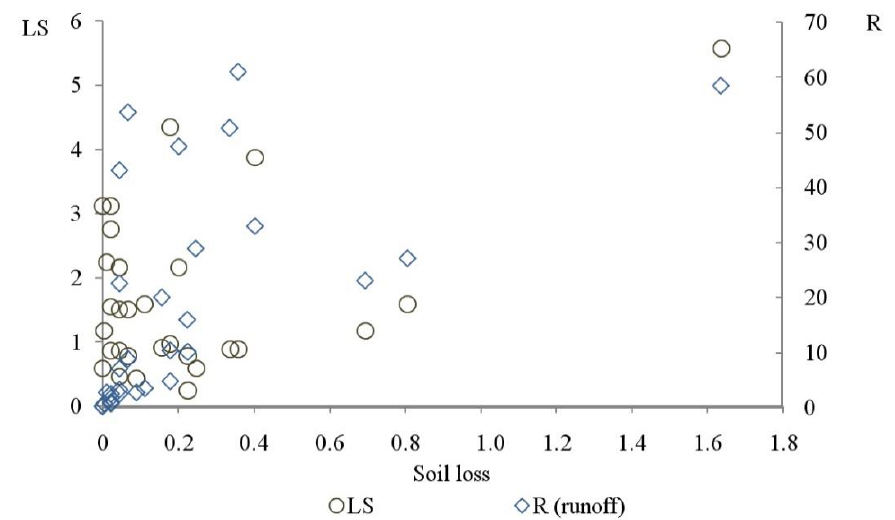
Figure 2. Distribution of the soil loss values (t ha − 1 year − 1 ), depending on the values of the relief function (LS) and runoff (R, mm). Source data from Ref. [38].